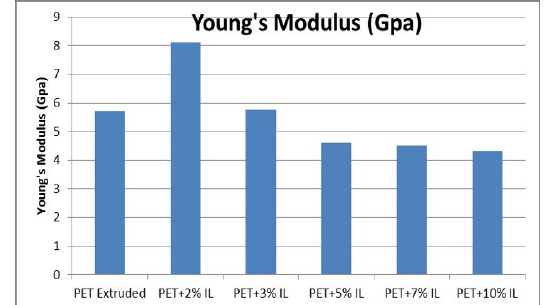
Figure 8. The Youngs modulus of the prepared PET-IL blends.